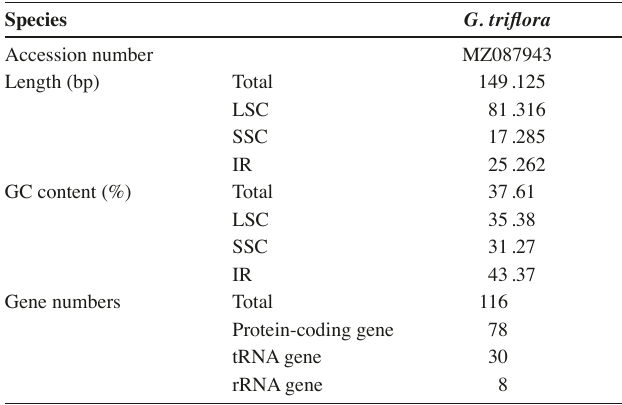
Tab. 1: Basic features of chloroplast genome of G. triflora .